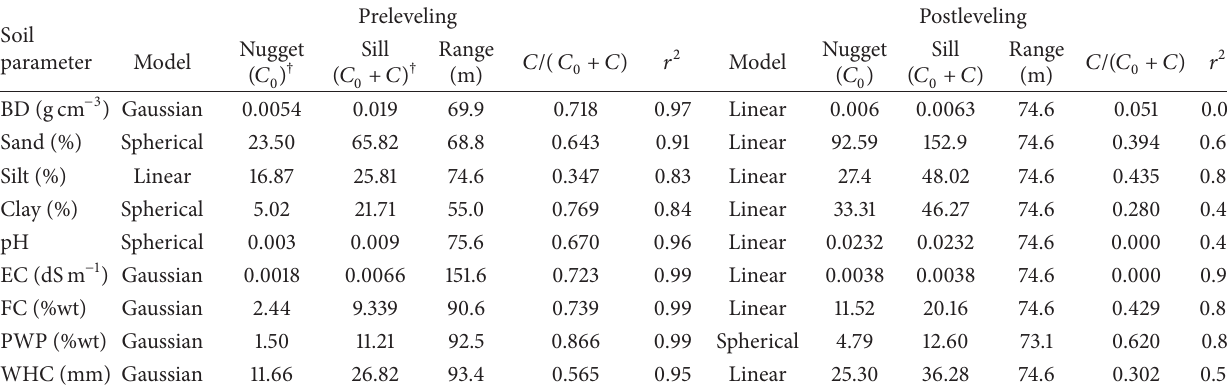
Table 4: Summary of geostatistical parameters for subsurface soil (20–40cm) properties measured before and after land leveling.